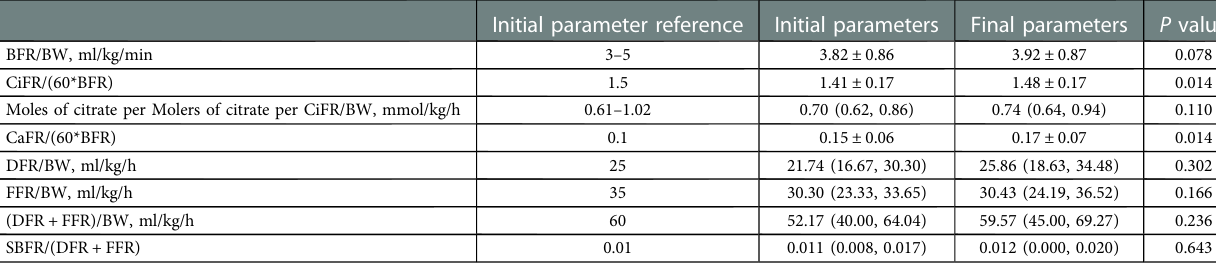
TABLE 1 Comparison of initial and fi nal